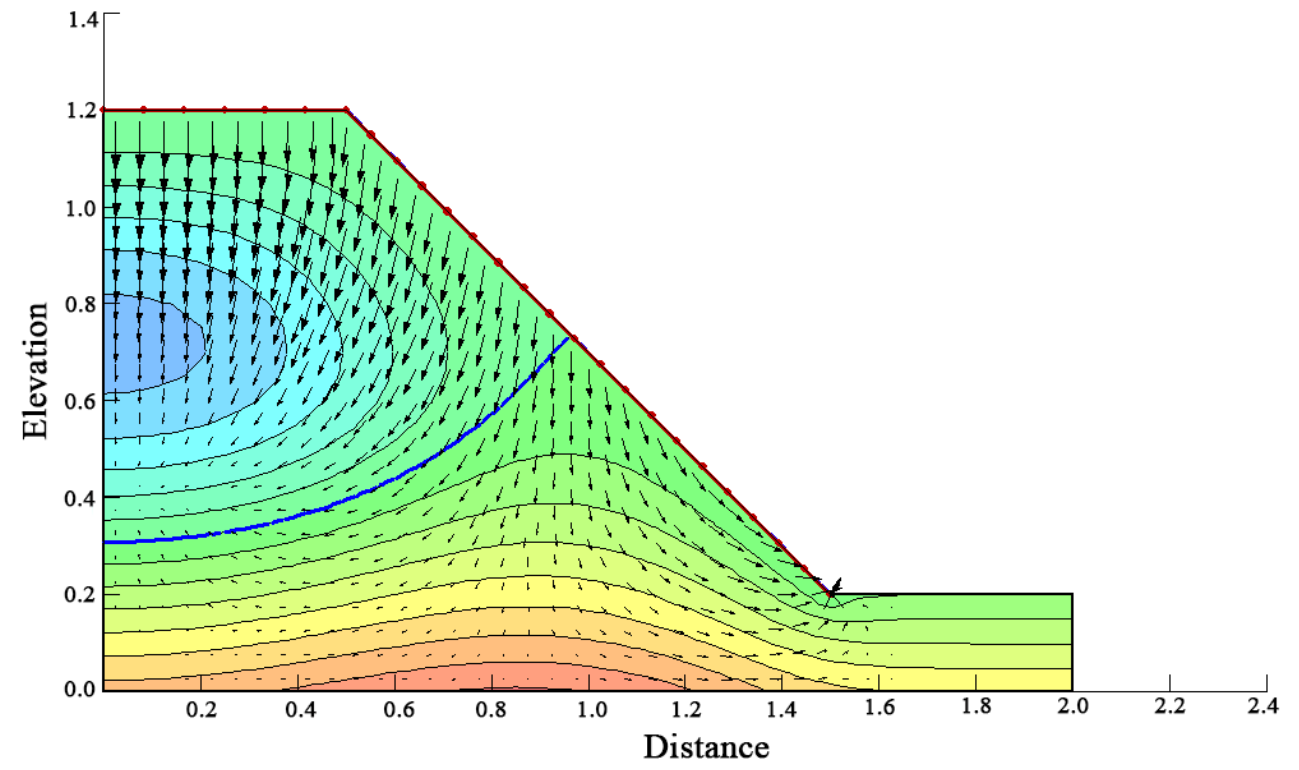
Figure 11. Changes of the slope phreatic line and seepage field after 3 h of rainwater infiltration. The seepage in the slope after 3 h at an intensity of 36 mm/h is shown in Figure 11. The phreatic line was higher after 3 h than after 2 h. The arrows were intensive at the top of the slope, the arrows were perpendicular to the inside of the slope first, then the arrows had a defined angle with the left border, and the width of the colored area increased gradually. The maximum water head at 36 mm/h was located at the bottom of the slope, and the minimum water head in the slope was between 0.62 and 0.82 m. The maximum and minimum water heads changed on the slope surface, but the minimum water head changed dramatically. The direction of infiltration was perpendicular to the slope surface above the phreatic line and nearly parallel to the slope surface and bottom. There was steady infiltration according to the analysis in 3 h. There were steady infiltration and unsteady infiltration in the slope in 3 h. The unsteady infiltration above the phreatic line in the slope was more obvious, the reaction between the water and soil was stronger, the